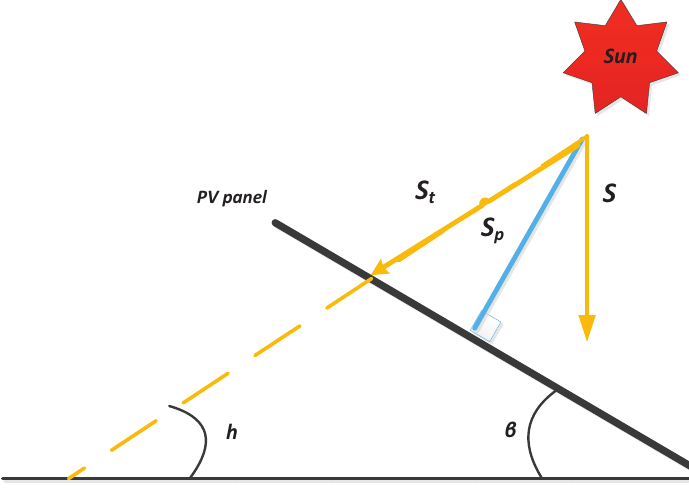
Figure 4. Representation of solar